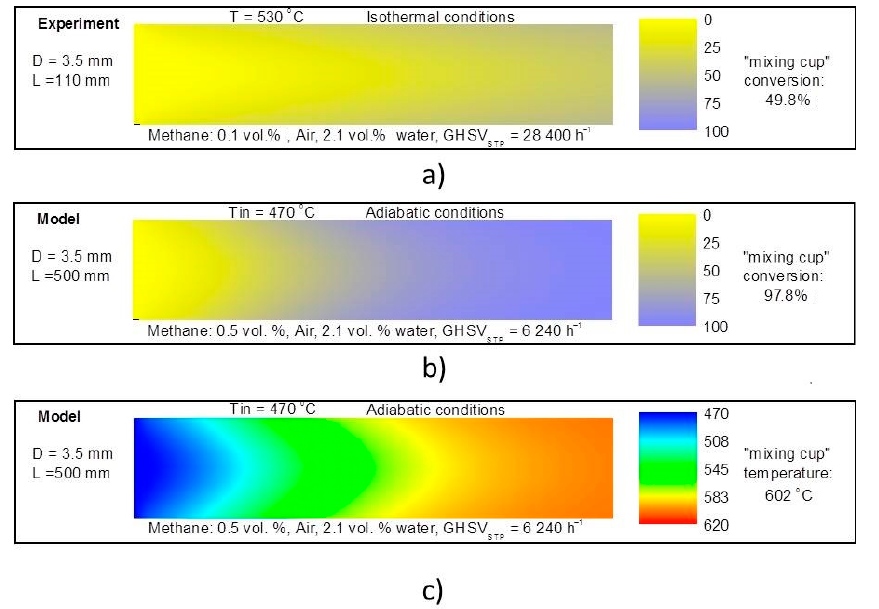
Figure 10. Experimental data on the activity of Pd-LMO/Imp/Aluchrom at isothermal conditions ( a ) and calculation of catalyst amount needed for 98.0% purification of waste gas (air) containing methane in presence of water vapor at adiabatic conditions ( b , c ).